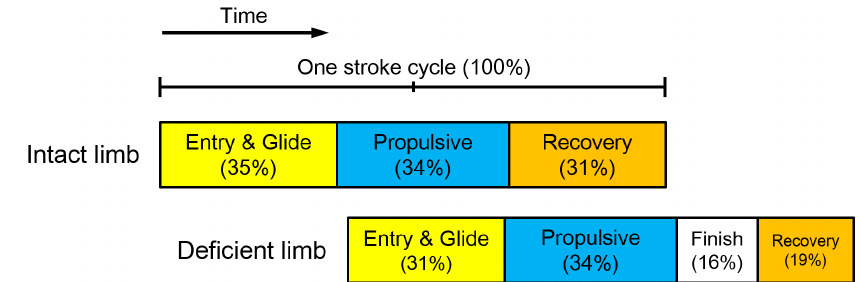
Figure 3. Schematic figure to show the coordination of the right (deficient side) and left (intact side) arms. The horizontal direction represents the time. The entry and glide phase is from the arm entry to the water and to the beginning of thrust production. The propulsive phase is the period when the thrust is produced by the arm. The recovery phase is the period when the arm is above the water surface. During the finish phase, which existed only for the right arm, the arm did not produce the thrust although the arm is still